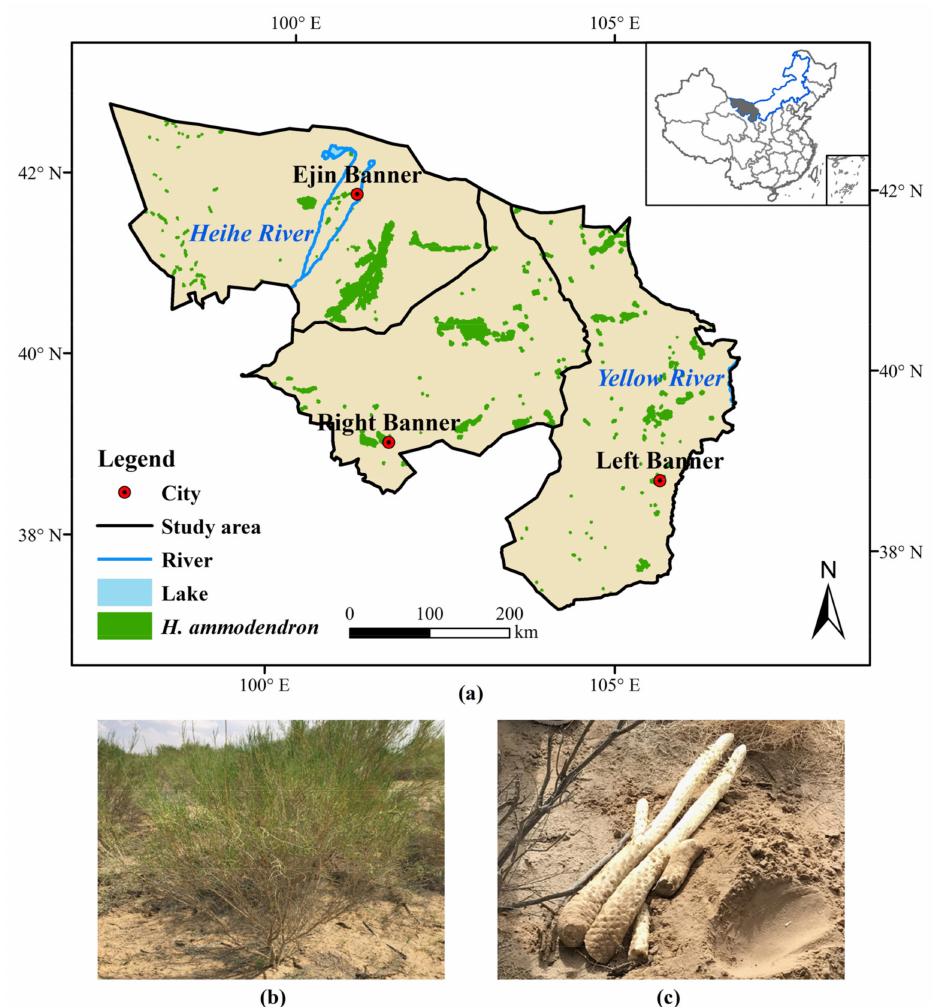
Figure 2. ( a ) Distribution of H. ammodendron (C.A.Mey.) Bunge in the study area; ( b ) H. ammodendron ; ( c ) C. deserticola